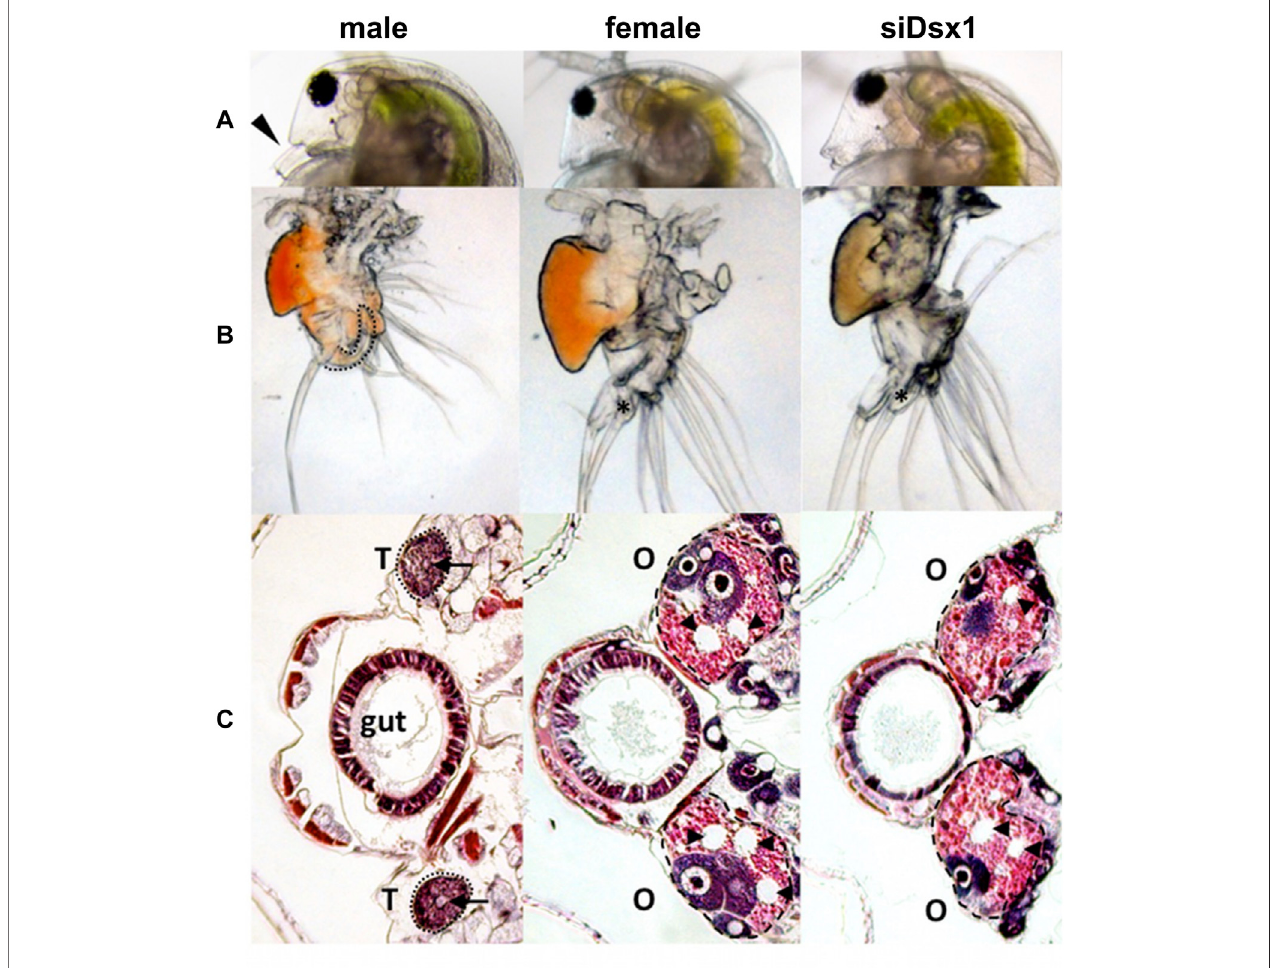
FIGURE8| Dimorphicdevelopmentof D.magna .Eggsinducedtobecomemaleswereobtainedfrom D.magna .AfterinjectionofthesynthesizeddsRNA,sexually dimorphic phenotypes were examined at the fi fth or sixth instar except for the fi rst antennae (third instar). The fi rst two columns represent normal male and female phenotypes, respectively. The third and fourth columns represent phenotypes of individuals injected with dsRNAs of dsx1 and dsx2 , respectively. (A) Lateral view of the head. Arrowheads indicate the fi rst antennae. (B) First thoracic limb. The dotted line shows the outline of the stout chitinized hook. A female-type long fi lament corresponding to the hook is labeled with an asterisk. (C) : Gonad. Daphnids were embedded in paraf fi n and sectioned, followed by standard hematoxylin and eosin staining. Dorsal is left, ventral is right. Dotted circled lines show gonads at both sides of a gut. T and O indicate testis and ovary, respectively. Arrowheads indicate large lipid droplets lying among the eosinophilic yolk granules. Arrows indicate lumens into which the mature spermatozoa are released. Adapted from Kato et al. (2011).